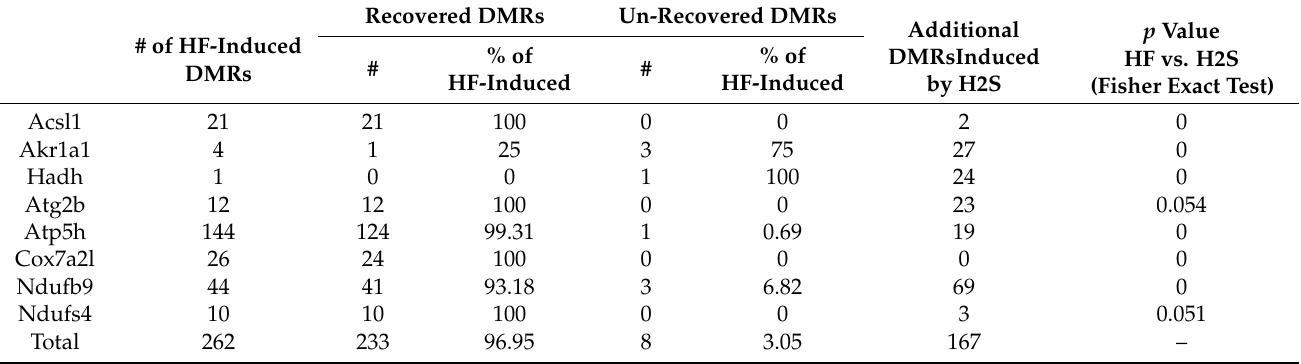
Table 3. DMRs induced by HF-diet and recovered by the H2S